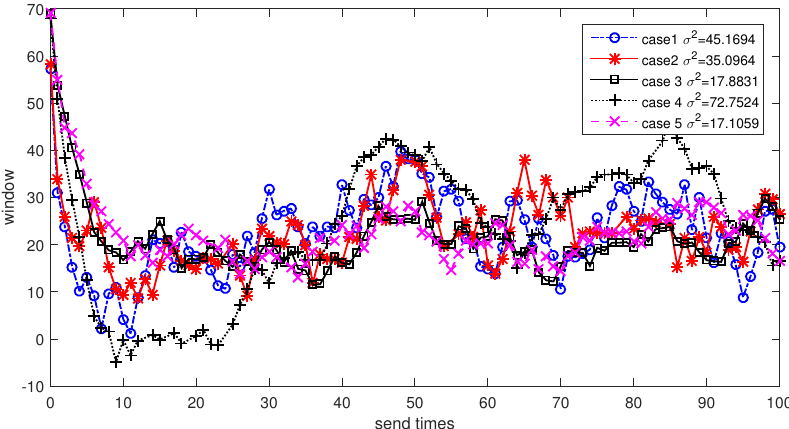
Figure 11. Window size estimation at relay node 2 for different loop filter